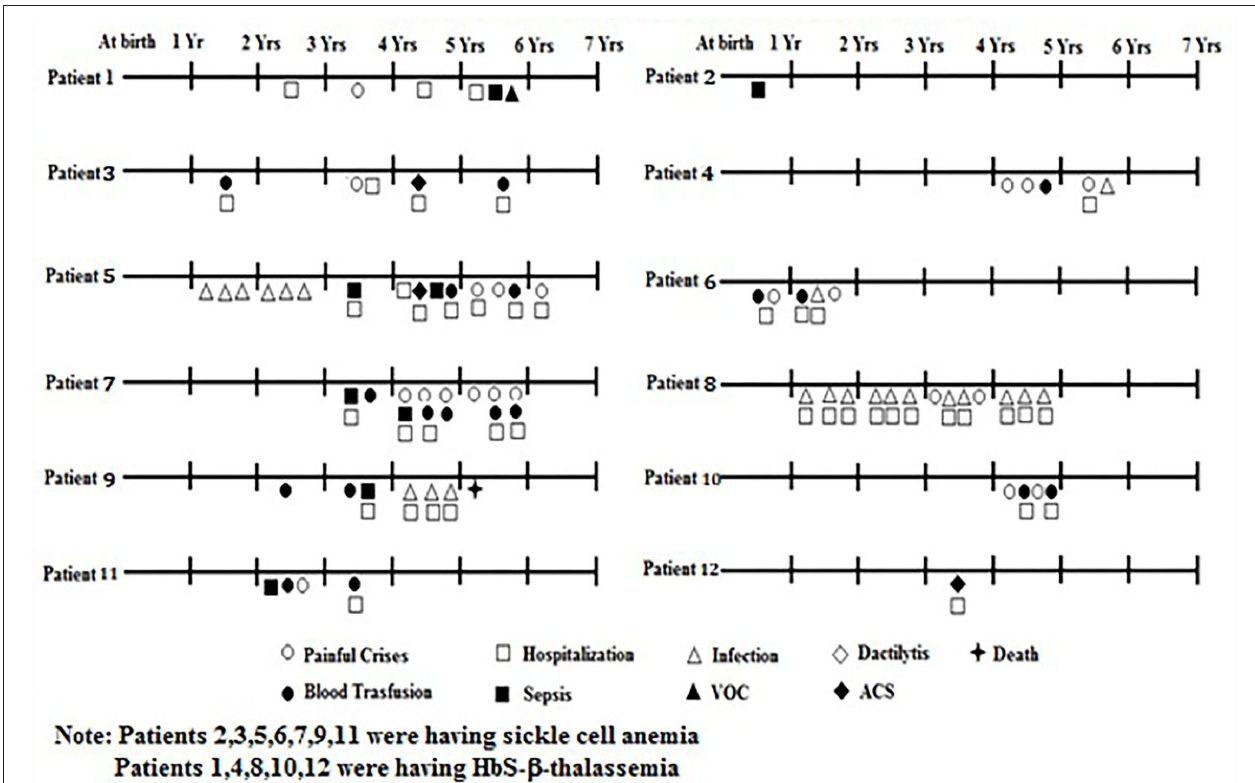
FIGURE 2 | Follow Up of babies with SCD having a moderate to severe clinical presentation.